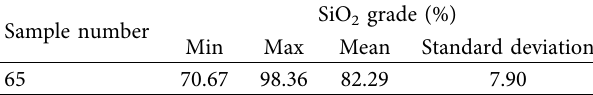
Table 1: Descriptive statistics of samples. Sample number